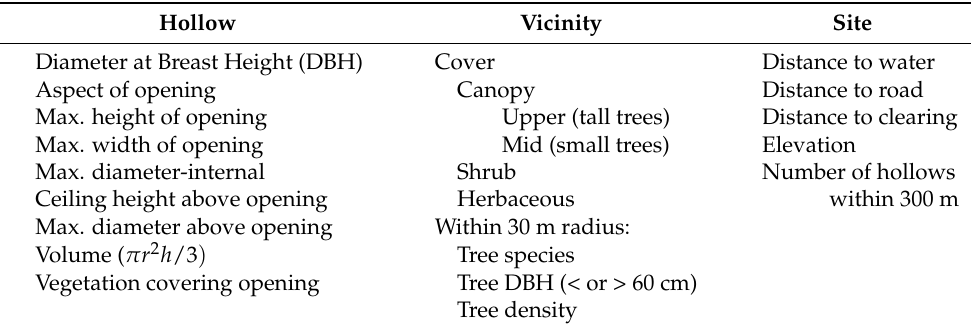
Figure 2. Diagram of basal hollow measurements (meters). DBH = Diameter at Breast Height; Enclosed Diameter = internal diameter above opening; Ceiling Height = height from top of opening to ceiling; Below Ground Height = height from ground level to bottom of hollow. Table 1. Tree-hollow characteristics used as predictor (independent) variables for bat use, as indexed by guano mass. All measurements in meters; vegetation cover estimated by